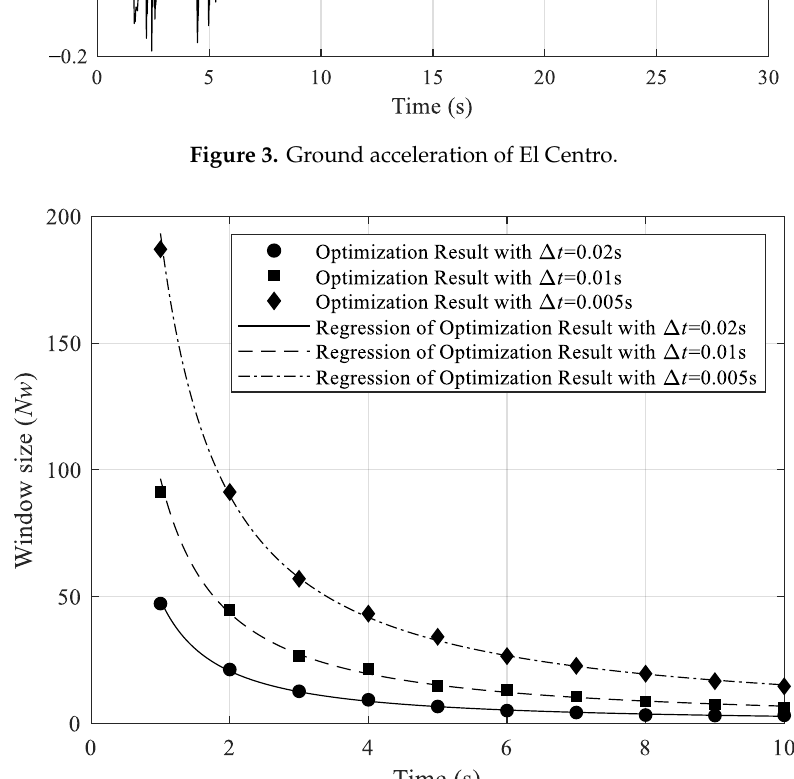
Figure 4. Optimization results of N w value with respect to various frequencies and interval times.